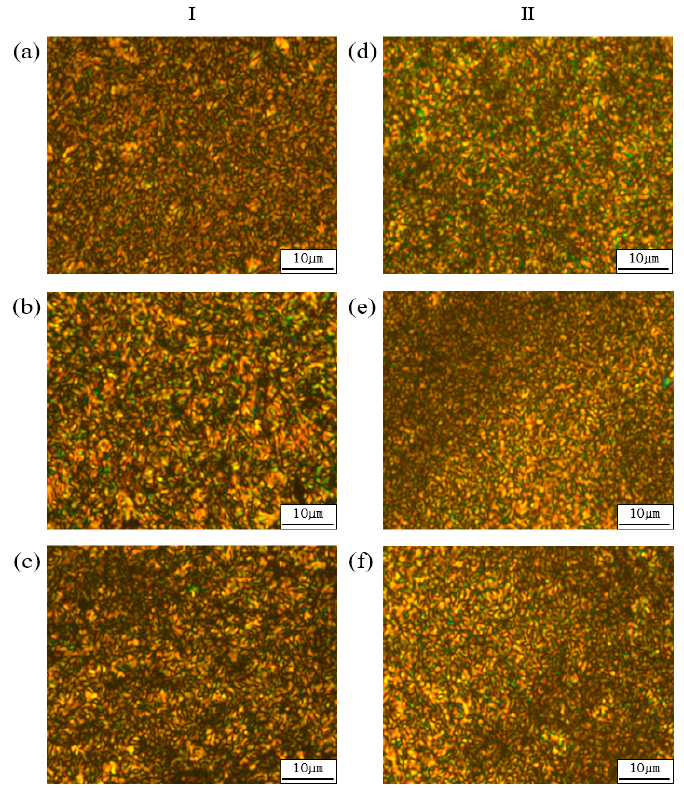
Figure 5. Polarized optical micrographs of ( a ) I-D at 280 °C, ( b ) I-E at 300 °C, ( c ) I-F at 270 °C, ( d ) II-D at 280 °C, ( e ) II-E at 295 °C, and ( f ) II-F at 315 °C (magnification 200×).